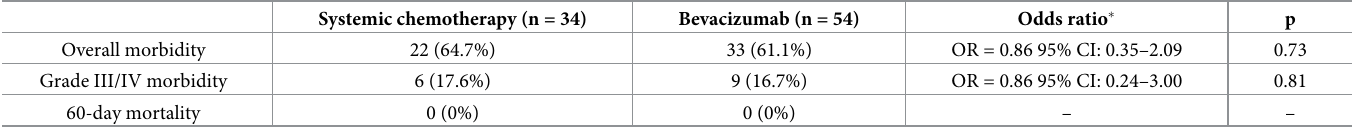
Table 2. Morbidity and 60-day mortality in patients receiving systemic chemotherapy alone or in combination with bevacizumab. Systemic chemotherapy (n =